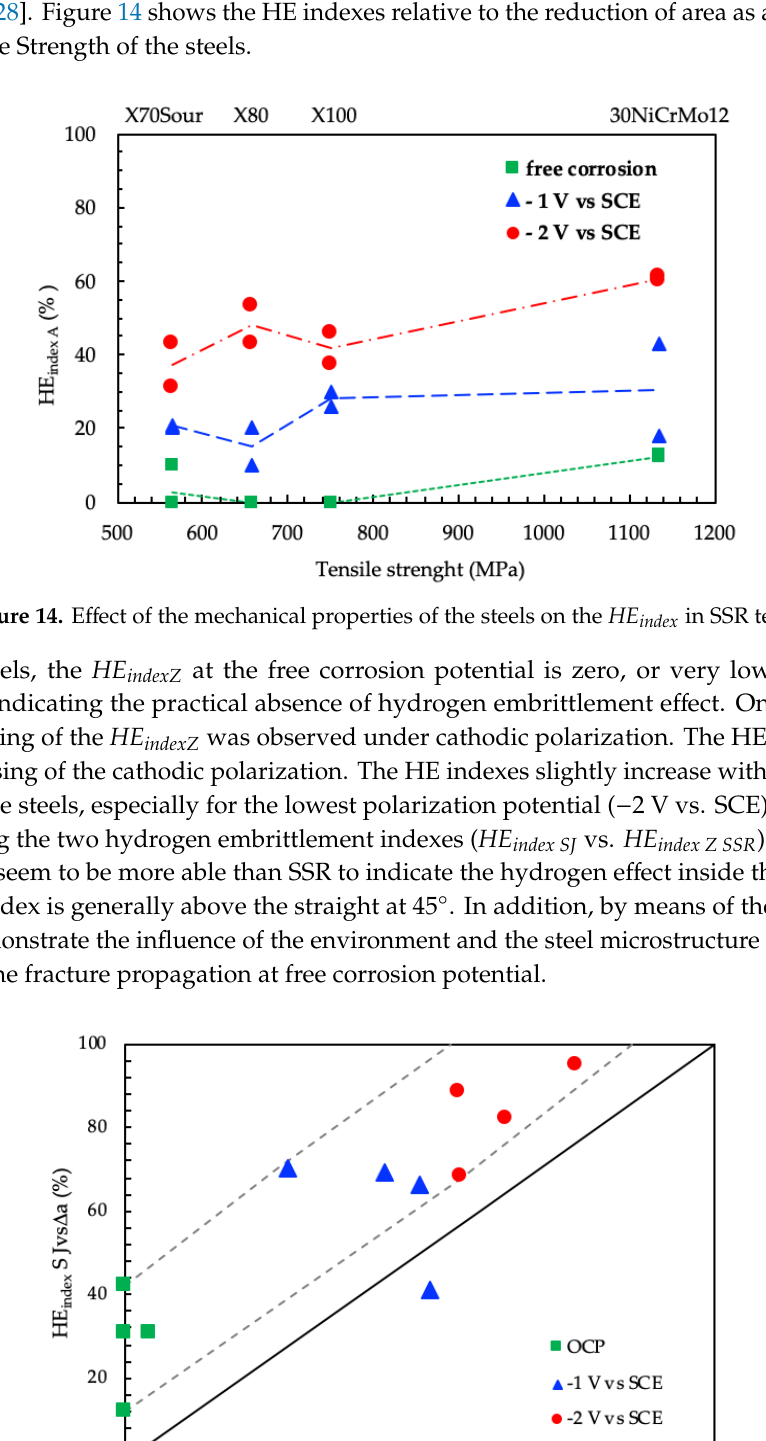
Figure 15. Correlation between the average values of the HE index SJ vs. HE index Z SSR.